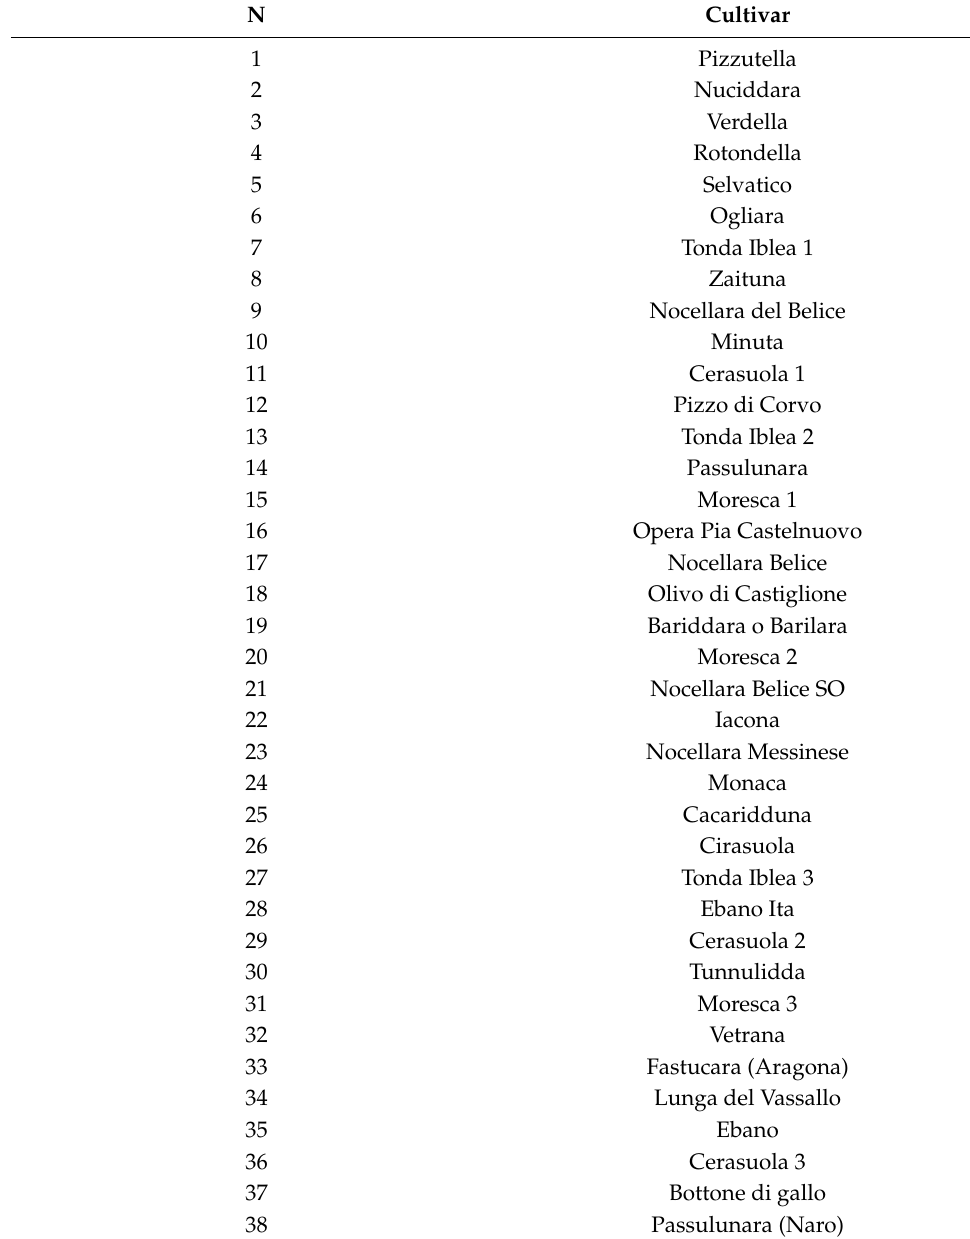
Table 1. The indigenous Sicilian olive cultivars